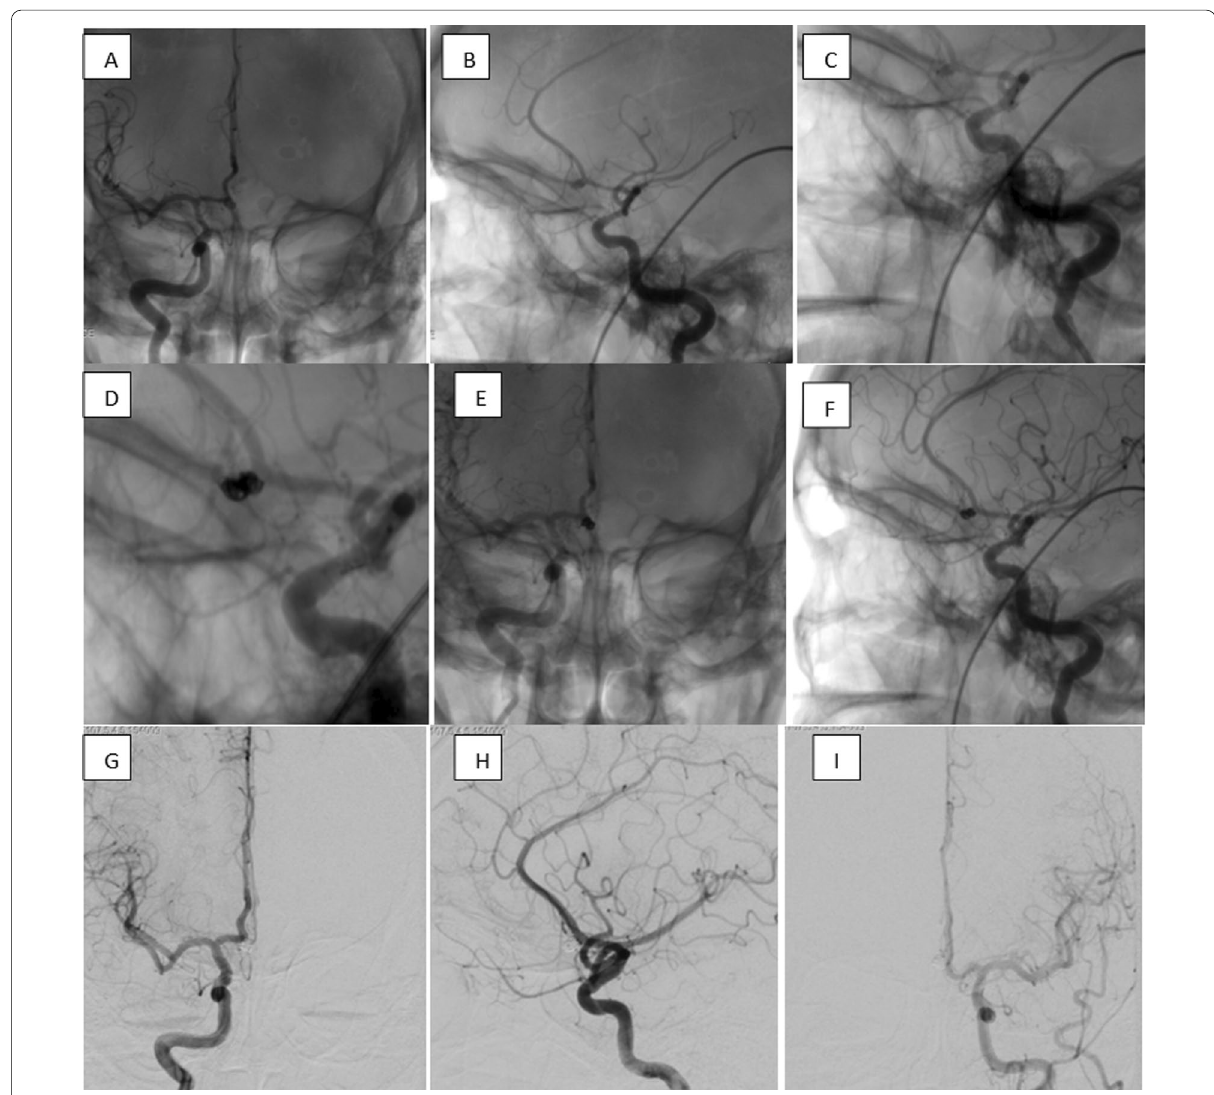
Fig. 1 Anterior communicating artery aneurysm with 4.1‑mm fundus and 3.8‑mm neck (dome‑to‑neck ratio of follow‑up shows complete occlusion of the aneurysm ( G – I